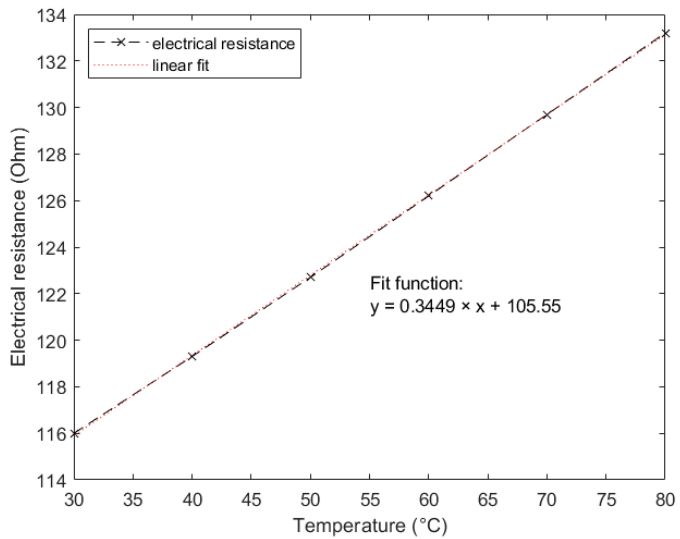
Figure 6. TCR measurement of 11 mm-long gold heater with 5 µm width on silicon dioxide thin film. Electrical resistance was measured at temperatures between 30 and 80 °C in steps of 10 °C. The resistance at measurement temperature R h ,0 = 113.7 Ω .